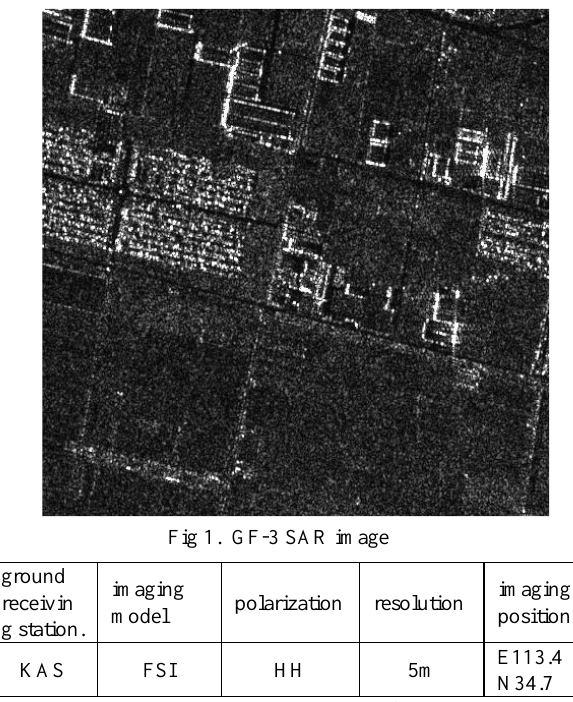
Table 1 . The parameters of